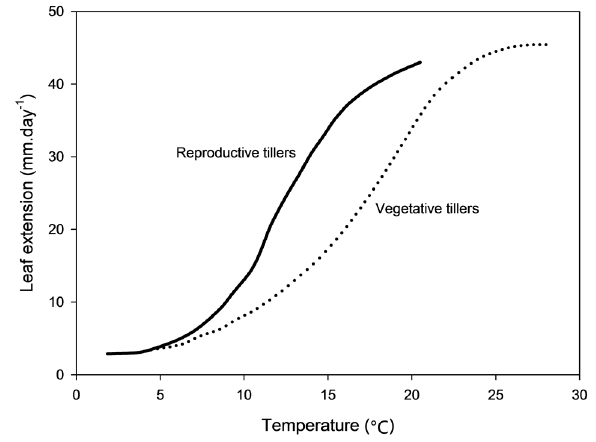
Figure 2. Contrasted responses of leaf extension to temperature before and after flowering induction in perennial ryegrass. Adapted from [30] with data from